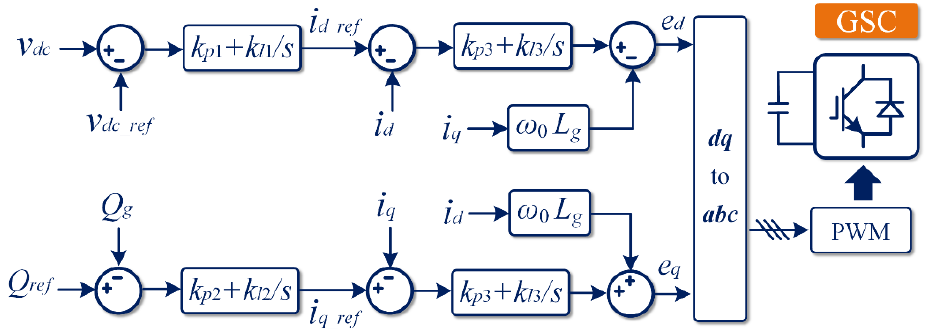
Figure 9. Control block diagram of the